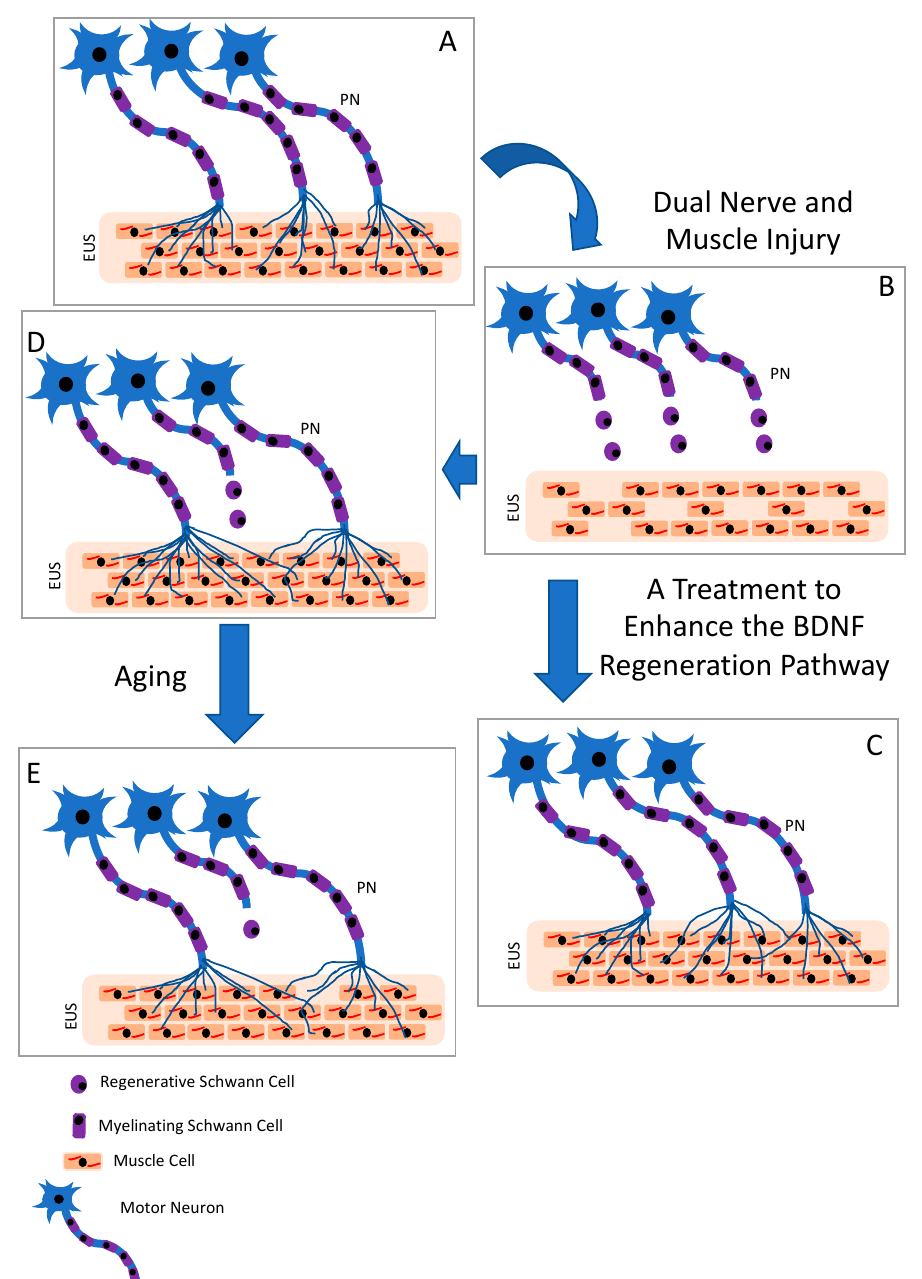
Figure 6. Summary diagram. A normal external urethral sphincter (EUS) is innervated by the motor neurons of the pudendal nerve (PN), as shown in ( A ). An injured EUS and PN has decreased innervation, as shown in ( B ). Treatments that enhance the BDNF regenerative pathway could enhance neuroregeneration of the PN and re-innervation of the EUS, as shown in ( C ). Unassisted regeneration of the PN results in increase in muscle fibers innervated by a single motor neuron, as shown in ( D ). With time after unassisted partial regeneration, axons atrophy with aging, as shown in ( E ).